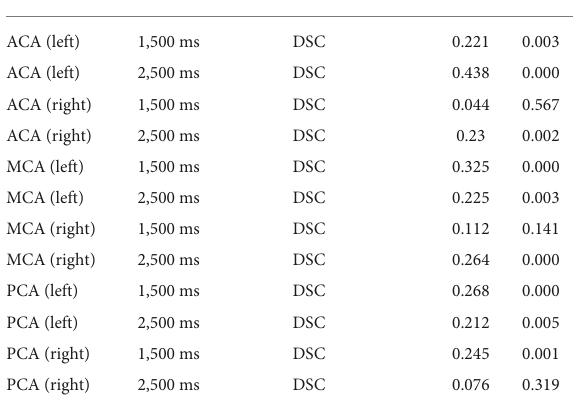
TABLE 3 The correlation between dynamic susceptibility contrast-cerebral blood flow (DSC-CBF) and arterial spin labeling (ASL)-CBF after